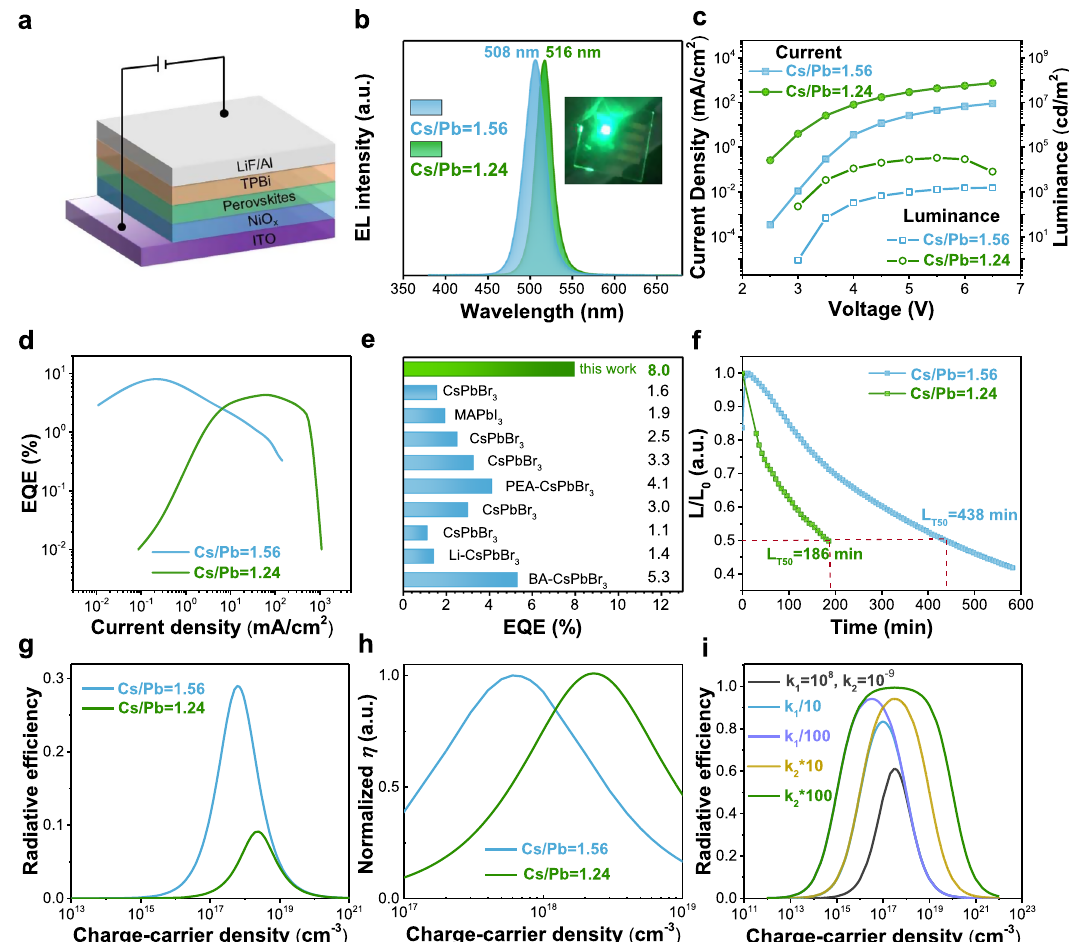
Fig. 3 The performance of Cs-Pb-Br PeLEDs. a The diagram of PeLED structure. b The normalized electroluminescence spectra of Cs/Pb = 1.56 and Cs/ Pb = 1.24, the inset is the photo of a Cs/Pb = 1.24 LED driven at 4 V. c Current density and luminance versus voltage characteristics of the PeLEDs. d EQE- current density curves of these two devices. e The EQE summary of thermally evaporated PeLEDs so far reported 25 – 27, 36, 51 – 55 . f Operational stability of devices at an initial luminance of 100 cd/m 2 . g The simulated radiative ef fi ciency evolution with carrier density by using the fi tted recombination constants. h The normalized radiative ef fi ciency η as a function of the carrier density. i The effect of k 1 and k 2 on the radiative ef fi ciency with k 3 fi xed. k 1 /10 means k 1 is 10 7 while k 2 remains invariable (10 − 9